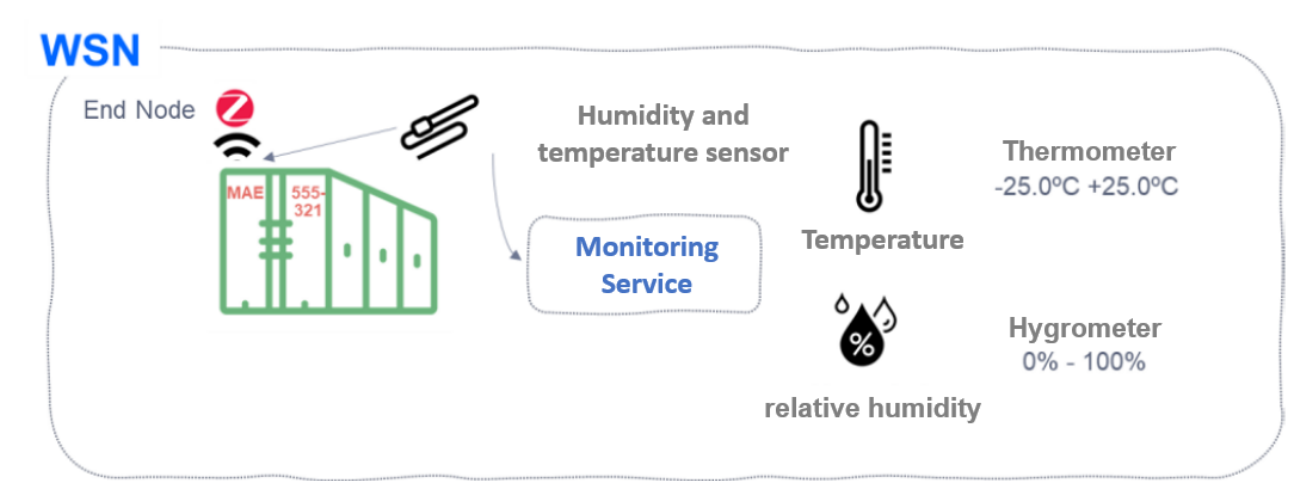
Figure 8. Monitoring of temperature and relative humidity in the